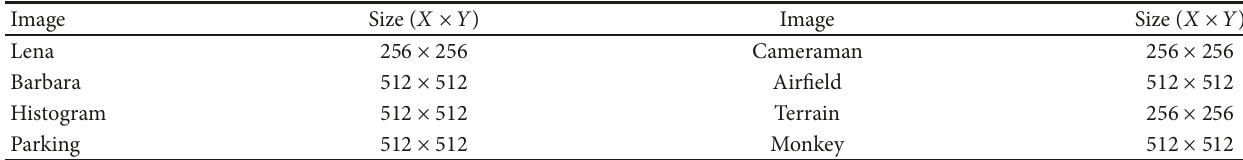
Table 1: Testing